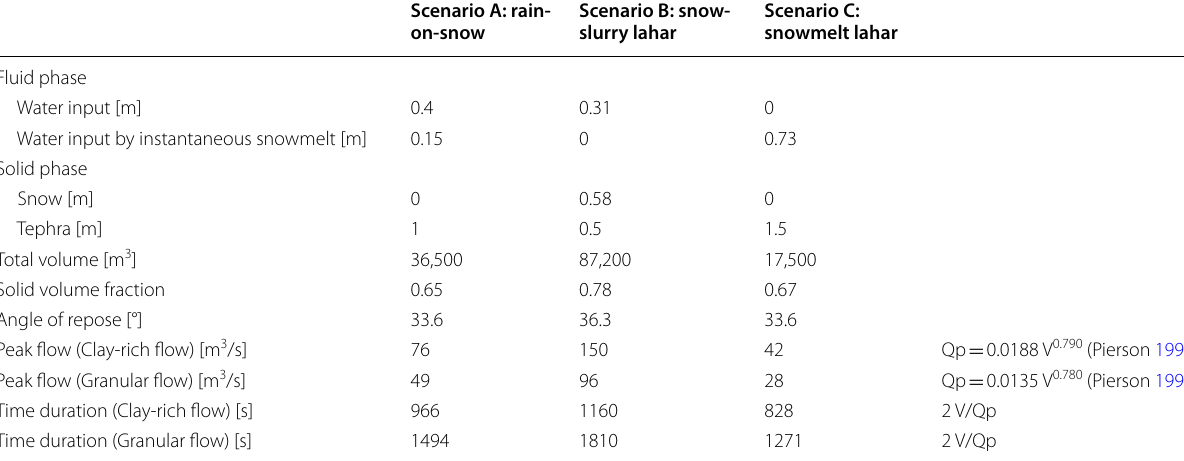
Scenario A: rain- Scenario B: snow- on-snow slurry